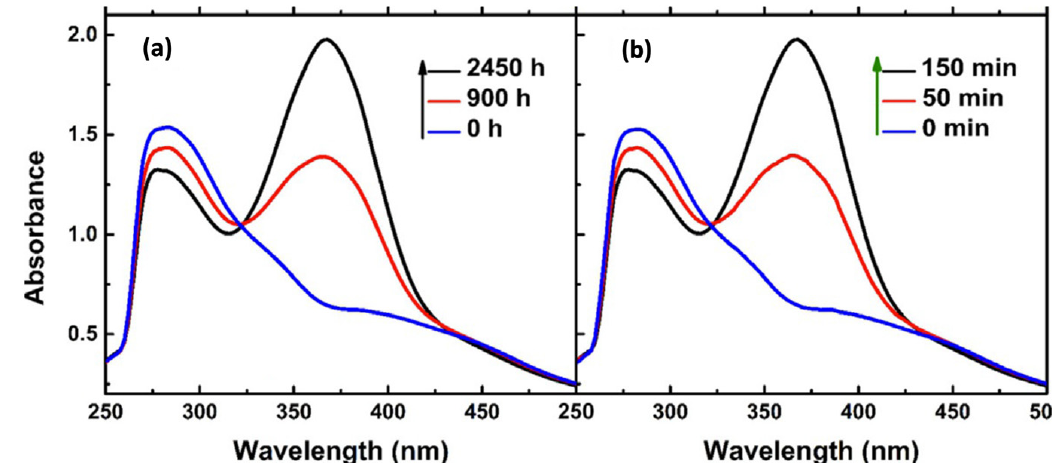
Figure 9. Time-evolved absorption spectra of rGO–bisAzo in (10 mgL − 1 ) Spectra of rGO–bisAzo-1 ( a ) in darkness and ( b ) irradiated with green light at 560 nm after UV irradiation. (Reprinted with permission from [98] Copyright @ 2017, John Wiley and Sons).